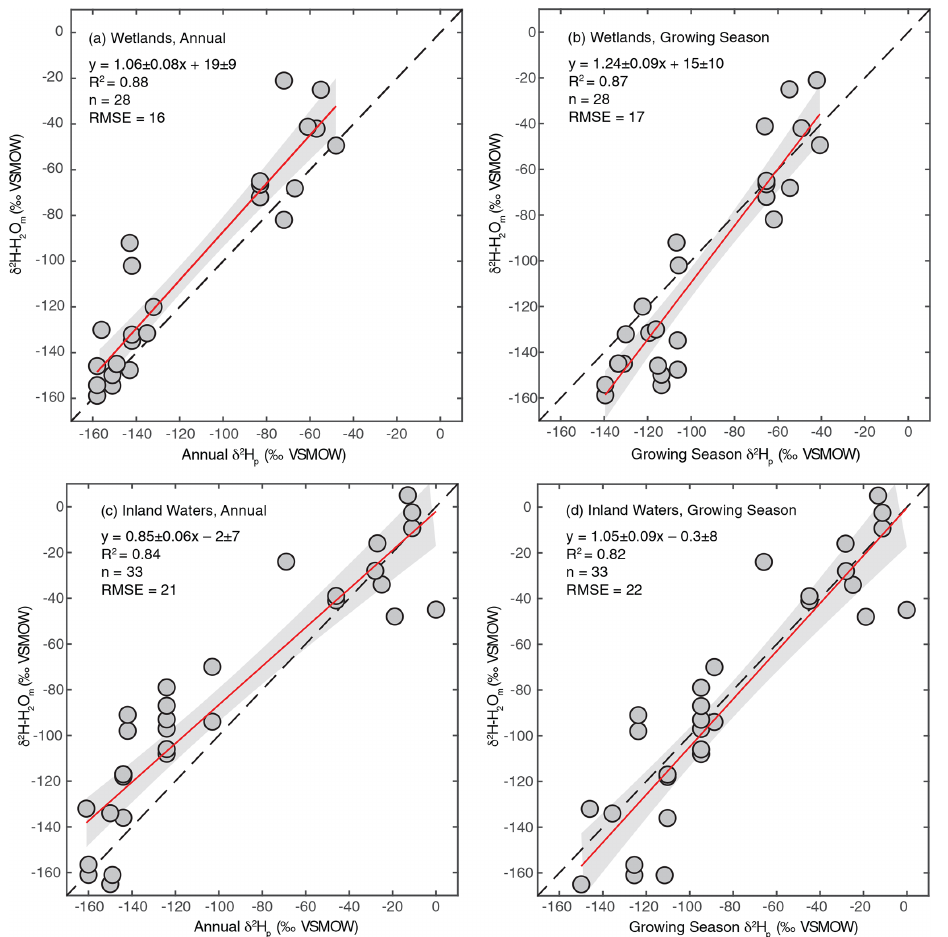
Figure 2. Scatter plots of annual or growing season δ 2 H p vs. measured δ 2 H–H 2 O for wetland (a, b) and inland water (c, d) sites. The red lines indicate the best fit, with a 95% confidence interval (grey envelopes), and the dashed black lines are the 1 : 1 relationship.